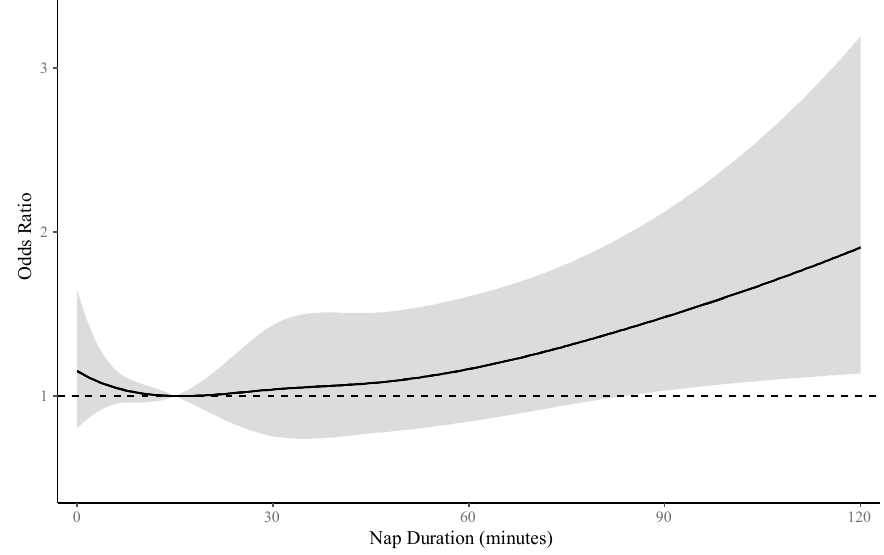
Figure 3. The dose-response relationship between nap duration and prevalence of metabolic syndrome. The curve was estimated by restricted cubic spline function with five knots and logistic regression model adjusted for age, gender, affiliation, marital status, position level, smoking status, drinking status, physical activity, mood symptoms, night sleep duration hours, bedtime at night, use of sleeping medicine, and sleep quality. The reference was set to 15 min. The shadow represents 95% confidence intervals of odds ratios. The dotted line represents level of odds ratio equal to 1.